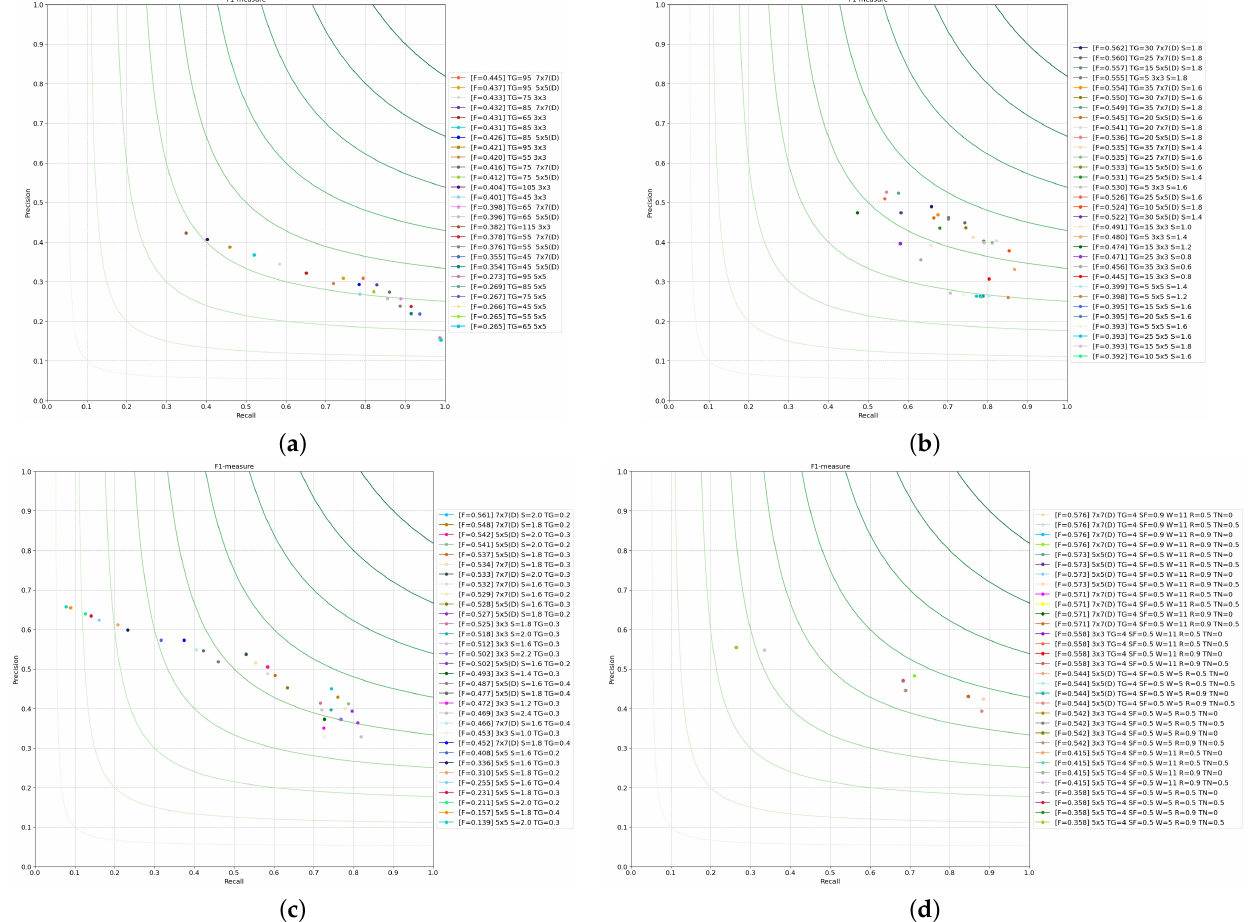
Figure 9. Finding the best results for classic, extended and dilated using different parameters for: ( a ) Laplace edge operator; ( b ) LoG edge operator; ( c ) Marr–Hildreth edge operator; ( d ) Shen–Castan edge